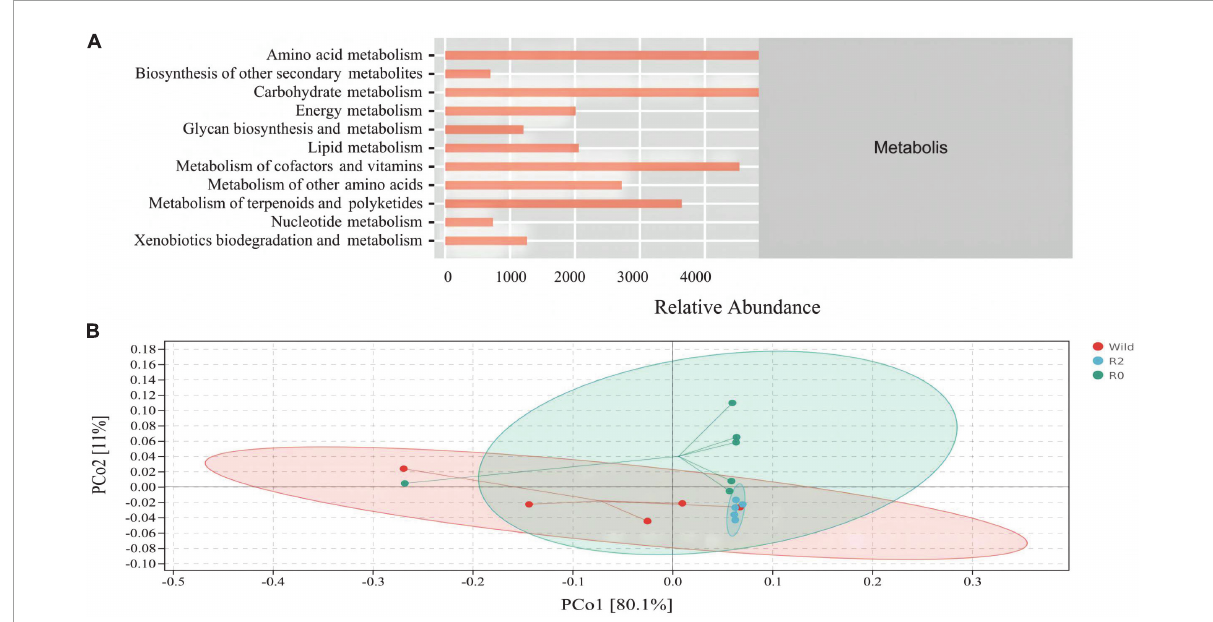
FIGURE6 The composition and structure of main microbial functions. (A) An abundance distribution plot of secondary function pathways in Metabolis according to PICRUSt2 function prediction. (B) A PCoA plot based on Bray-Curtis distance metrics associated with function dataset; colors represent sample sets of microbial functions (PCo1 = 80.1%, PCo2 = 11%).